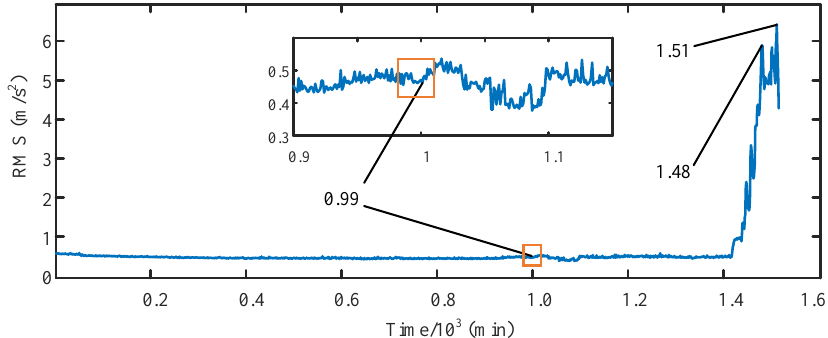
Figure 15. The RMS trend of vibration signal in Case 2.